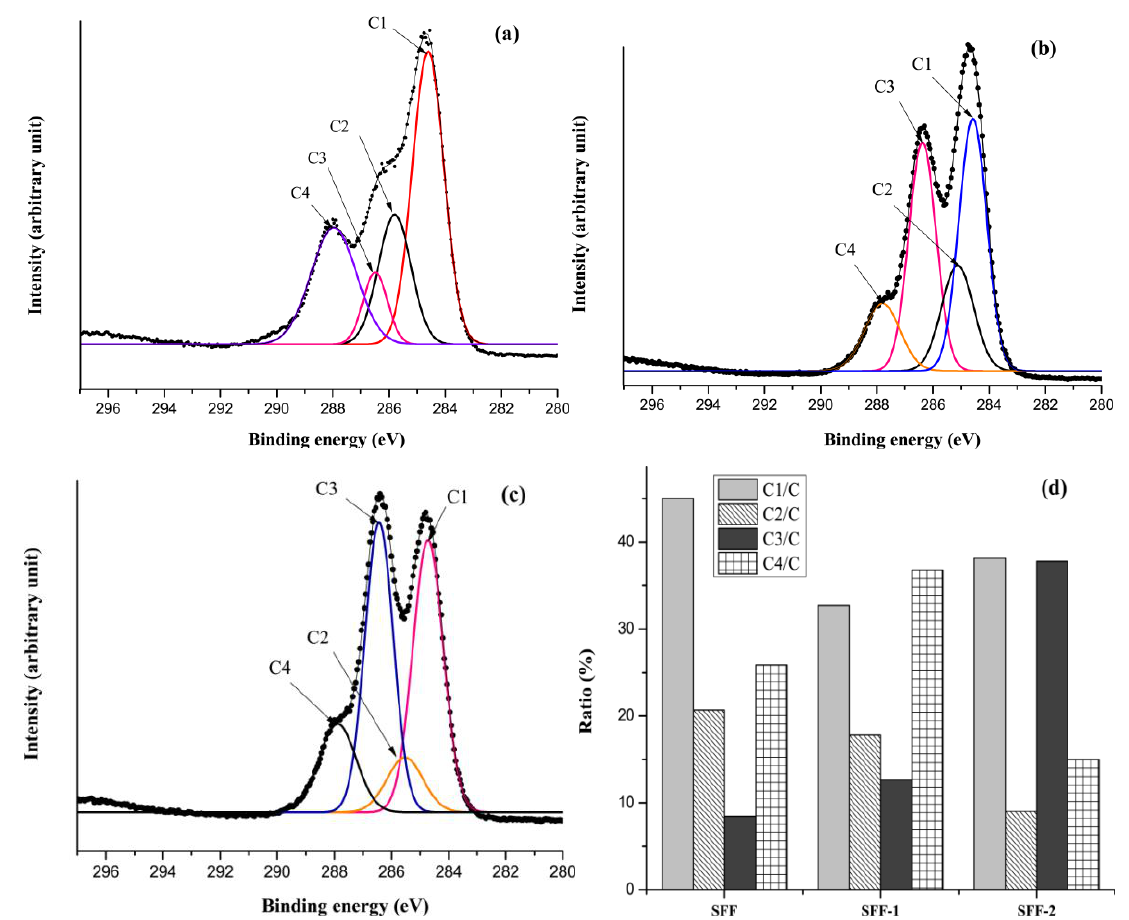
Figure 8. XPS spectra of C 1s peaks ( a ) SFF; ( b ) SFF-1; ( c ) SFF-2 and ( d ) relative elemental